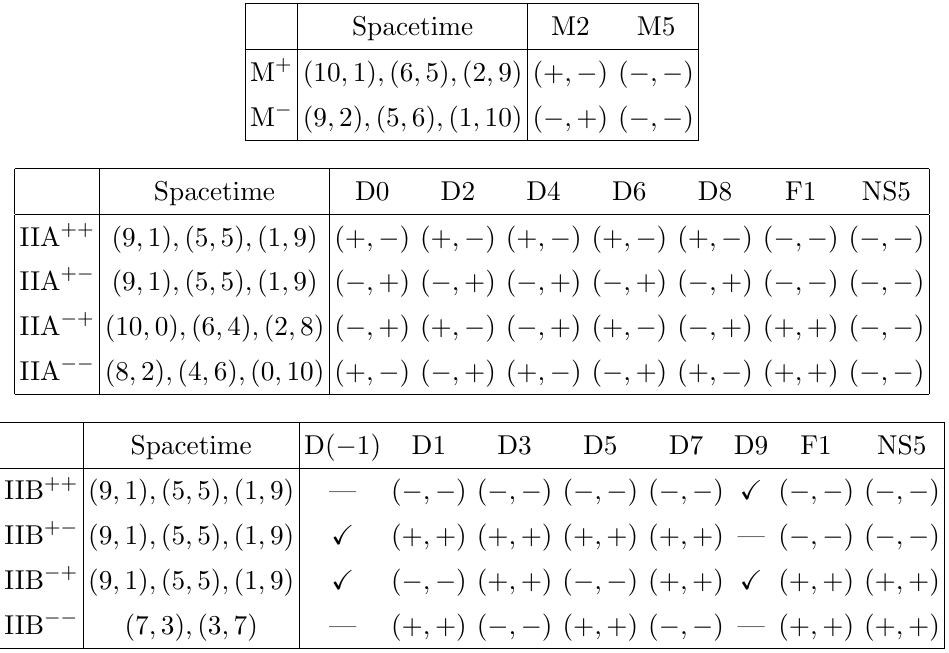
Table 2 . The available worldvolume and spacetime signatures for various type IIA, type IIB and M-theory variants. Here (+ ; (cid:0) ) indicates an even (+) number of worldvolume spatial directions and an odd ( (cid:0) ) number of worldvolume timelike directions, etc. For D( (cid:0) 1) and D9-branes we need only indicate whether the brane is present in the theory, since the former has no worldvolume and the latter (cid:12)lls